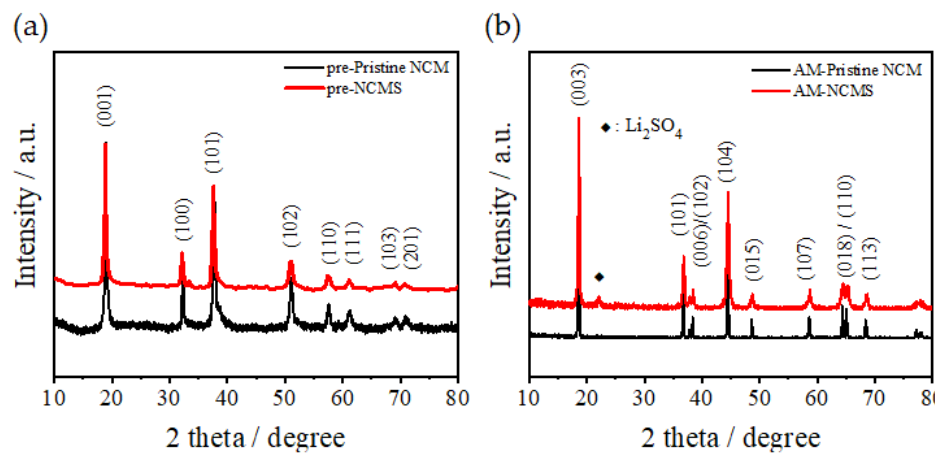
Figure 5. XRD patterns of the ( a ) precursors and ( b ) cathode active materials of pristine NCM and NCMS.